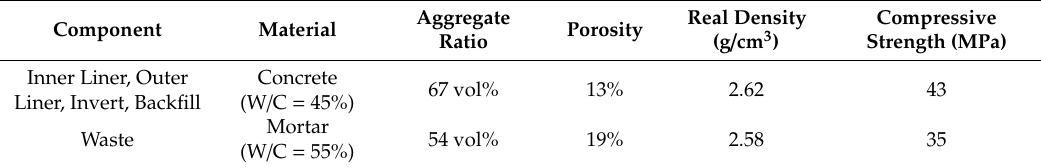
Table A3. Assumed specifications for cement components (from [12]).